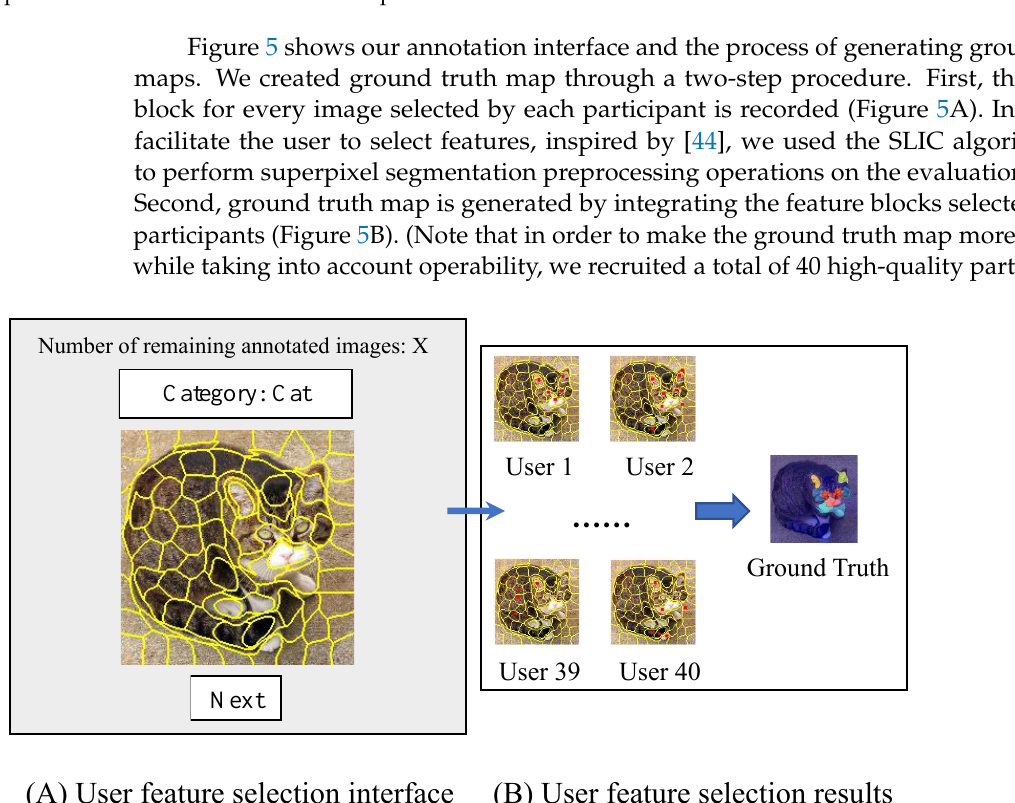
Figure 5. Overview of feature annotation interface. ( A ) is our main interface, which displays the segmented image and category information to be labeled, and also informs the user of the number of remaining labeled images. ( B ) means that we obtain the final ground truth by counting the feature blocks marked by different